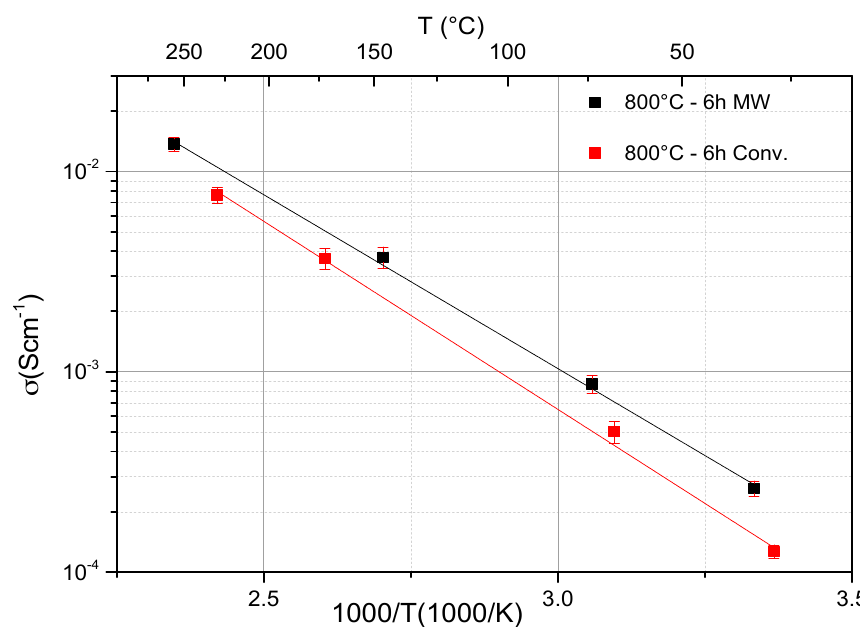
Figure 4. Ionic conductivity of LAGP glass-ceramics samples heat-treated at 800 °C for 6 h using 30 GHz microwave and conventional heating.